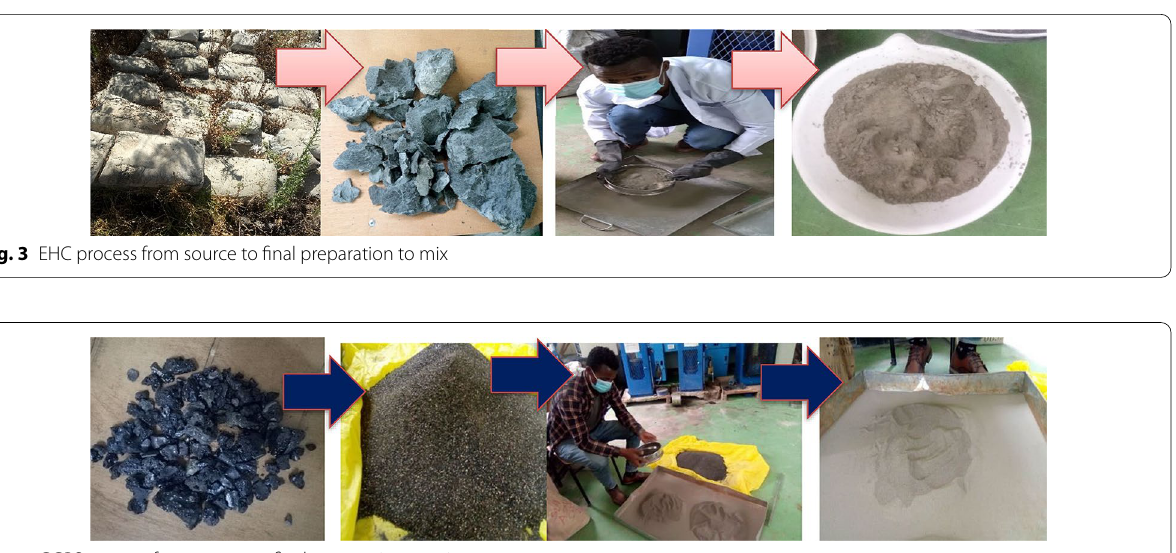
Fig. 4 GGBS process from source to final preparation to